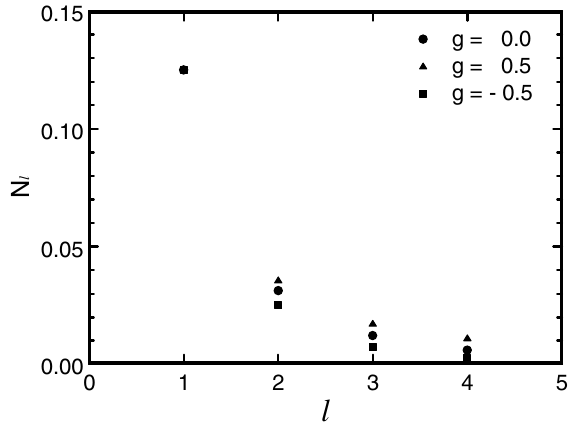
FIG. 2. The dimensionless multiple moment factor N for several densities with g (cid:4) 0 , 0.5, and (cid:7) 0 : 5 .